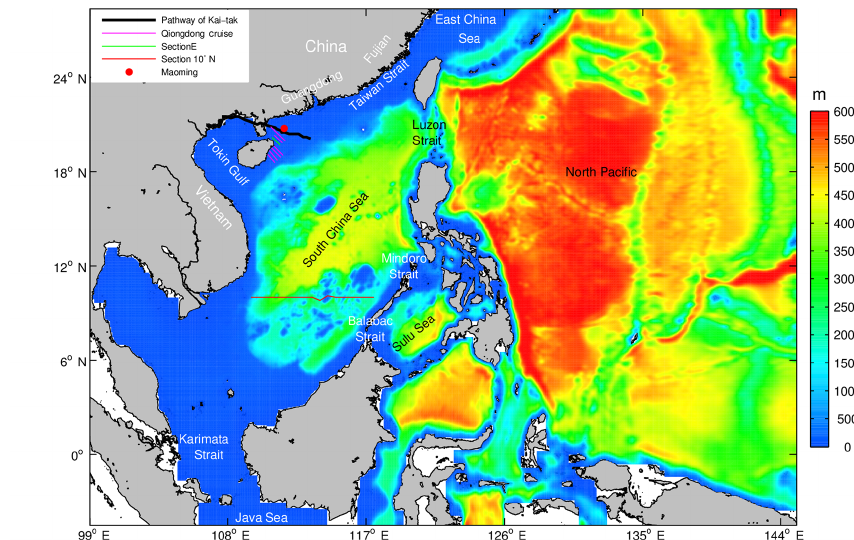
Figure 1. The model domain and bathymetry of